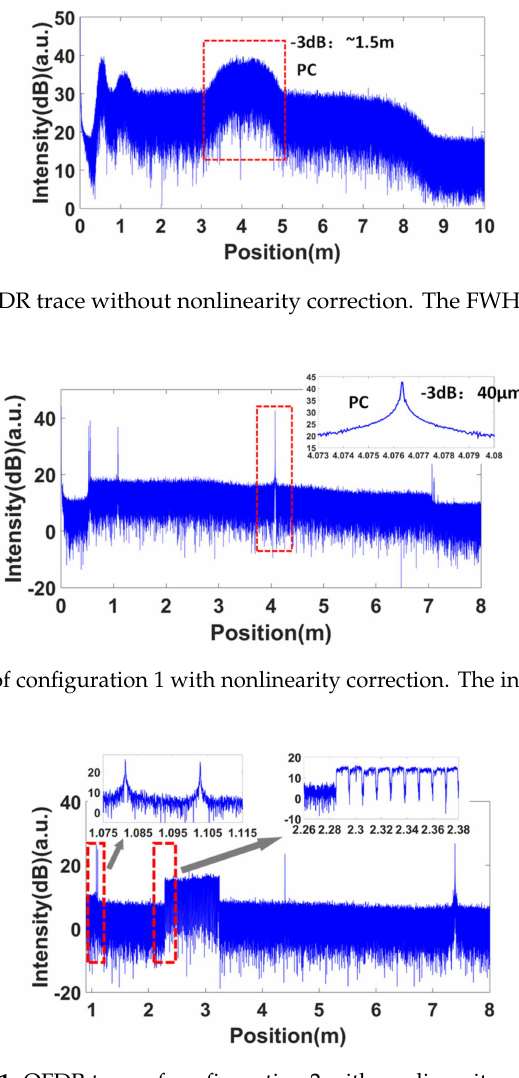
Figure 11. OFDR trace of configuration 2 with nonlinearity correction.